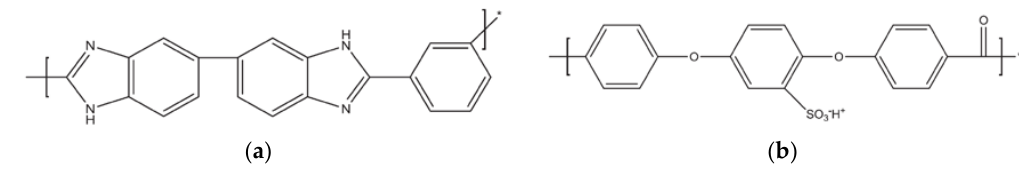
Figure 4. Structures of PBI ( a ) and SPEEK ( b ).